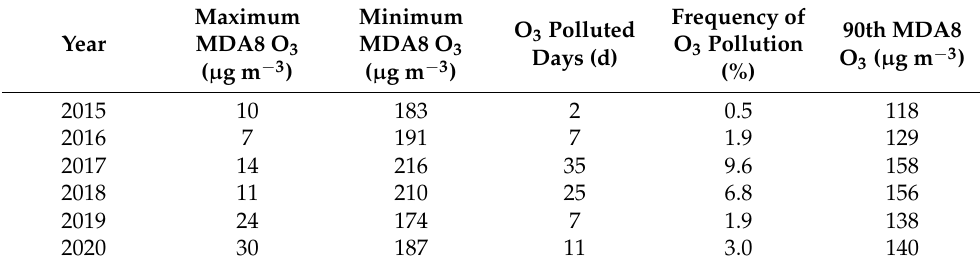
Table 1. The inter-annual variation of surface O 3 in PT during 2015–2020.